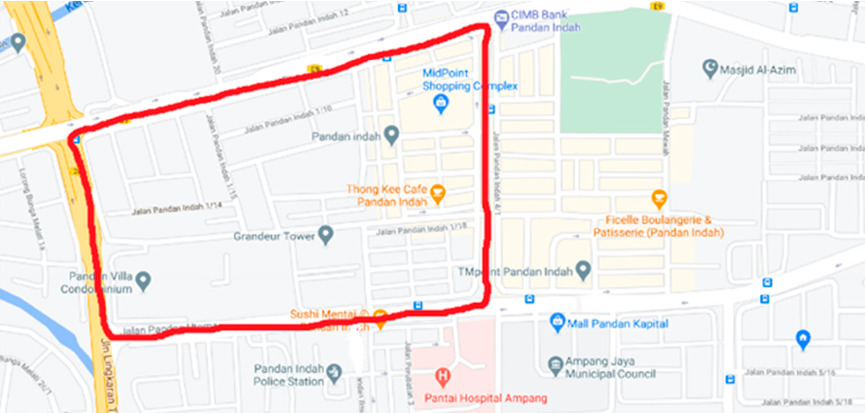
Figure 4. Routes followed in the mobile testing around the area of Pandan Indah, on 24 November 2020. (Source: Google Maps available at https://www.google.com/maps/place/Pandan+Indah,+Kuala+Lumpur,+Selangor/@3.1311177,101.7523725,16z/data=!4m5!3m4!1s0x31cc365f86dd4897:0xdb6d184b895e07c7!8m2!3d3.133892!4d101.7516751, accessed on 10 November 2020).